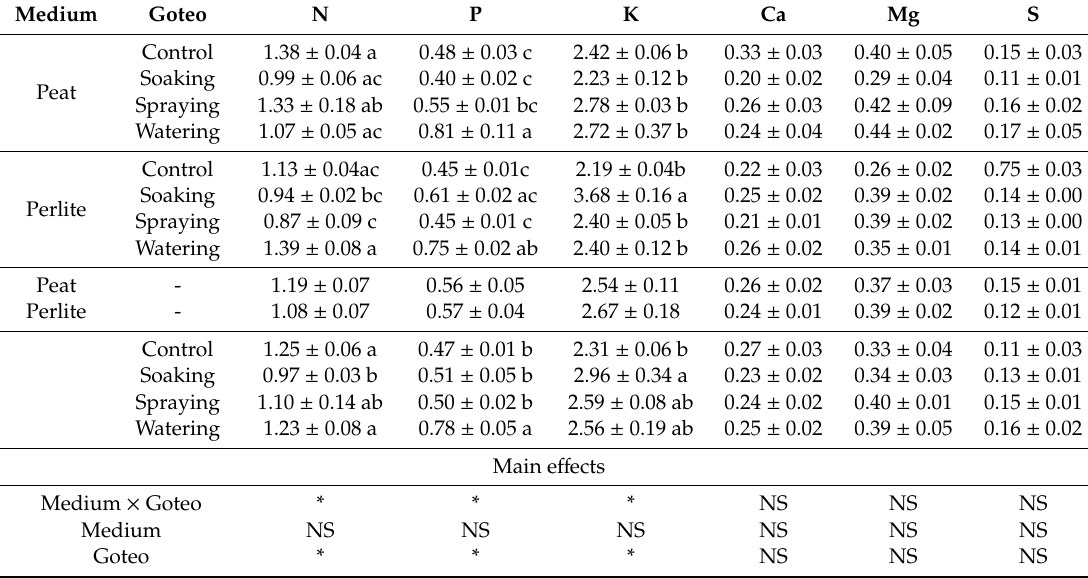
Table 4. Mineral composition of Pennisetum ‘Vertigo’ leaves after 2 months of pot cultivation: macroelements (% DW).